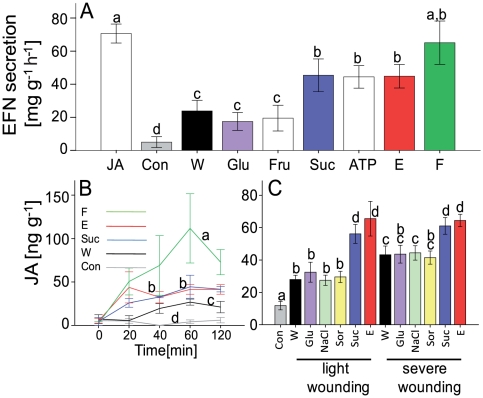
Damaged-self recognition in lima bean.(A) EFN secretion [mg soluble solids per gram leaf fresh mass and hour], (B) time course in endogenous jasmonic acid (JA) levels [ng per gram leaf fresh mass], (C) endogenous JA level 60 min after different treatments. Identical colors in different panels indicate identical treatments, values shown are means ± SE (of n = 7 biological replicates in panel A and n = 5 in panels B and C). Bars or lines marked with different letters indicate treatments that were significantly different (P<0.05) according to posthoc analysis with least significant difference tests. Abbreviations: Con = control, E = leaf extract, EFN = extrafloral nectar, F = flame wounding, Fru = fructose, Glu = glucose, Sor = sorbitol, Suc = sucrose, W = mechanical wounding.